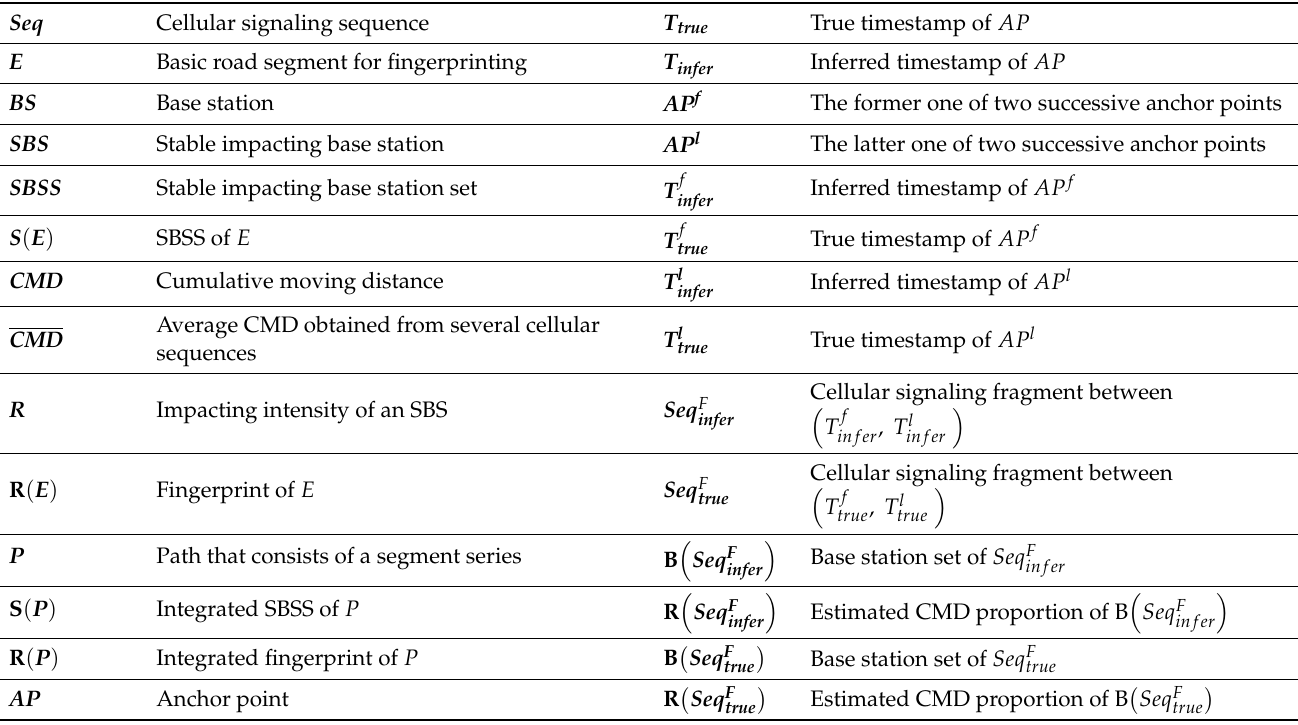
Table 2. Main notations in this paper.